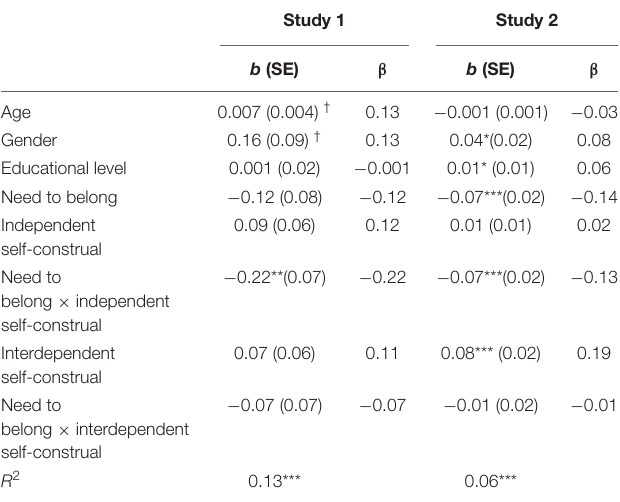
TABLE 2 | The results of regression analyses in Studies 1 and 2.